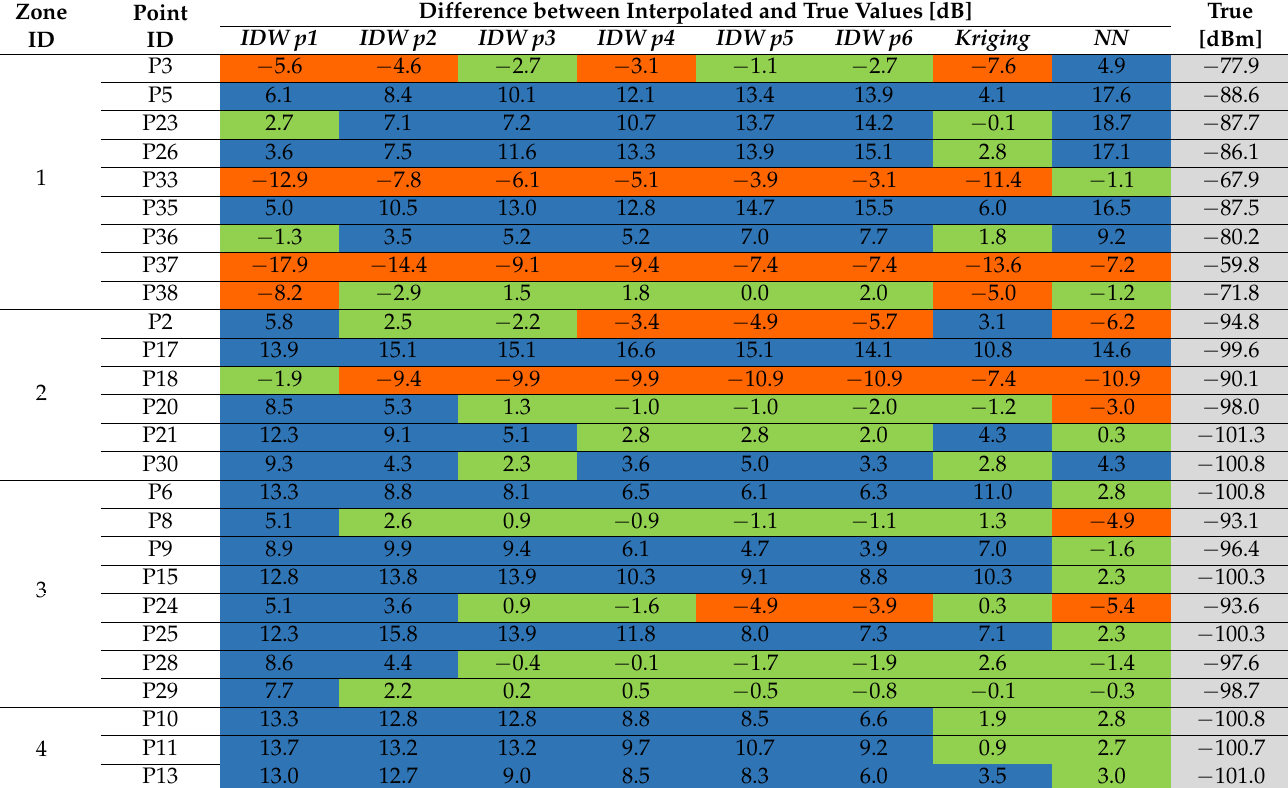
Table 3. Difference between interpolated and true value for 26 control points and various interpolation methods (Test_13a). Difference between Interpolated and True Values [dB] Zone Point ID ID